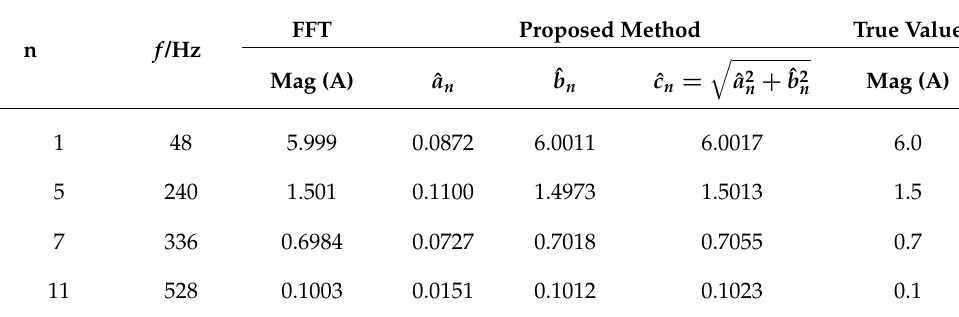
Table 3. Comparison of methods for harmonic